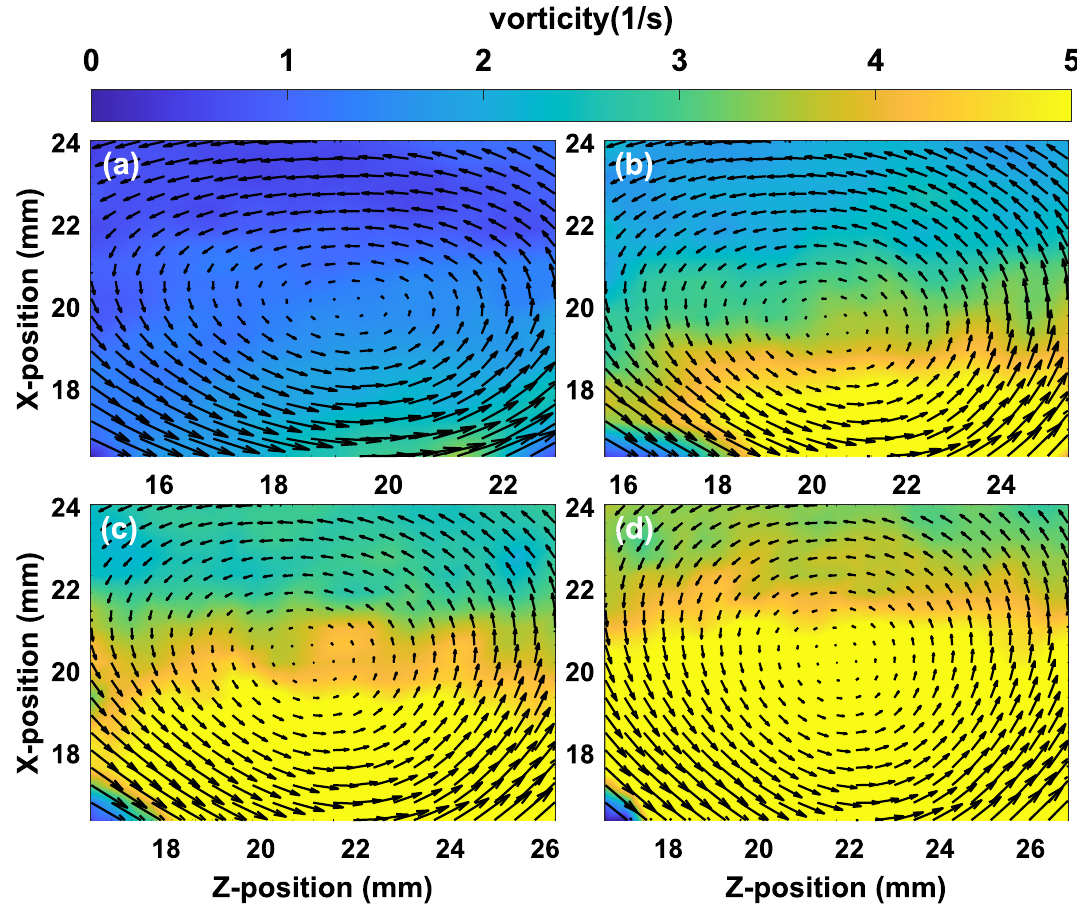
v ) around the vortex at the inlet pressures ( a ) 200 Pa, ( b ) |∇ × |